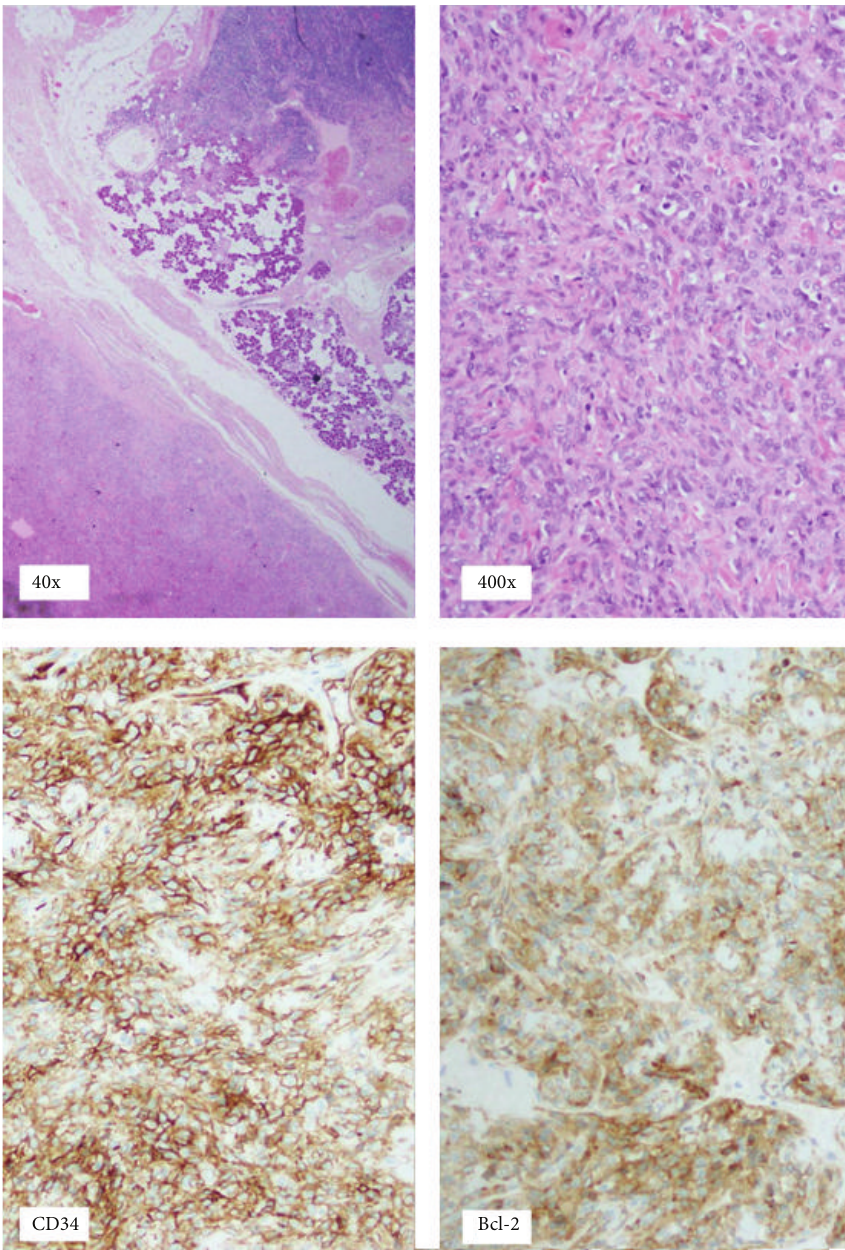
Figure 1: Hematoxylin and eosin staining at low magnification (40x) and high magnification (400x) showing a well circumscribed solid fleshy tan tumour within the parotid gland, with cords and nests of spindle-type cells. Immunoperoxidase staining was positive for CD34 and